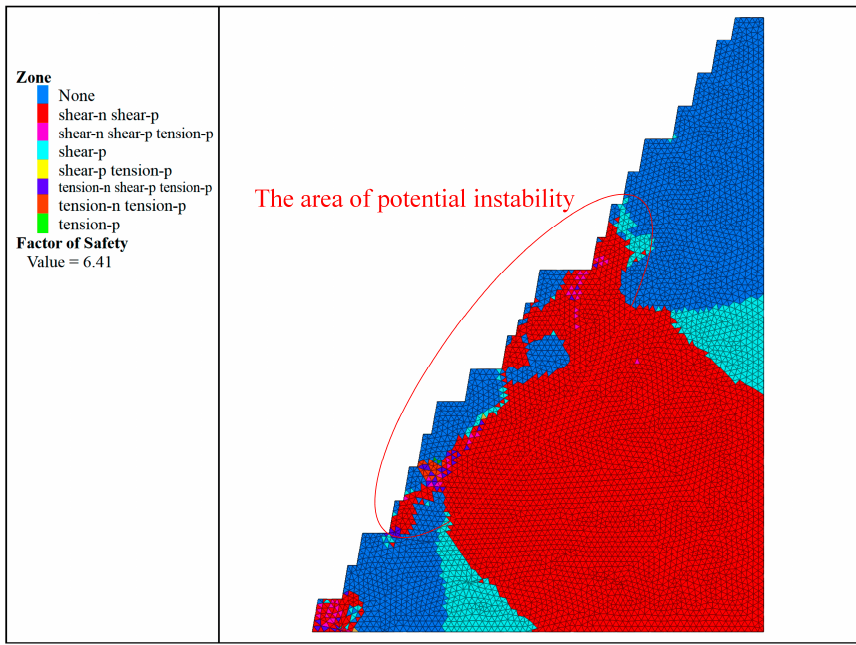
Figure 11. Results of the adjusted R3 slope for the strength reduction method.